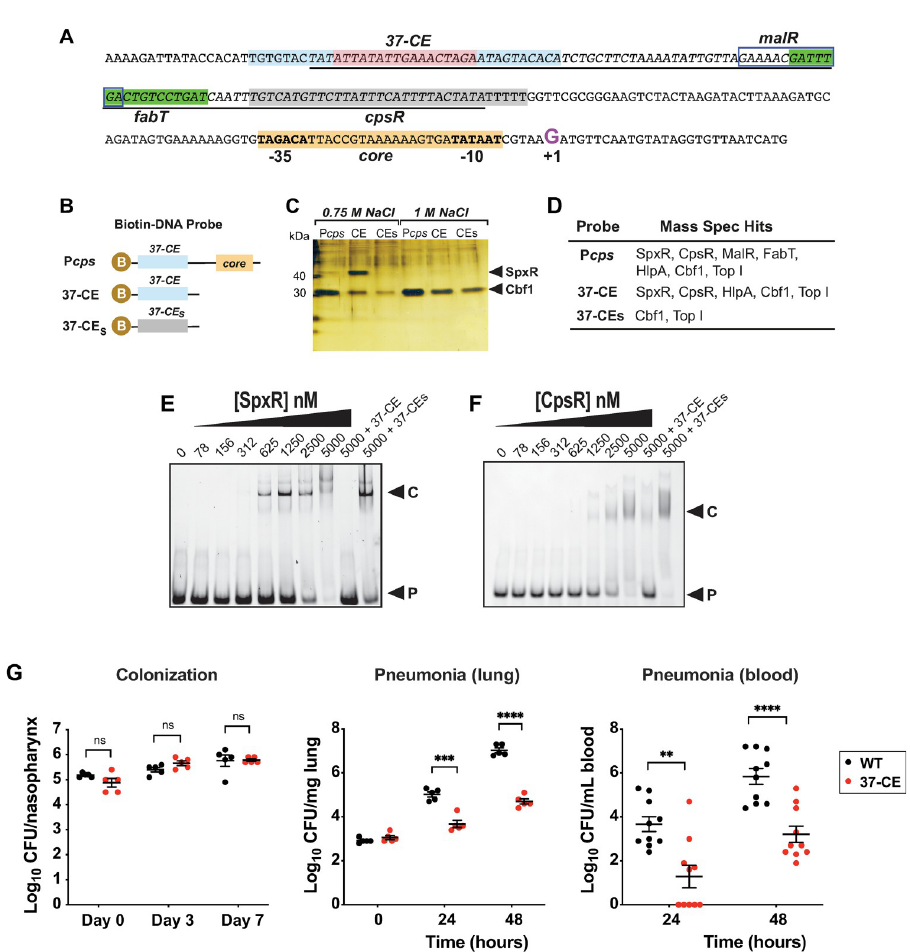
Fig 1. Identification and characterization of the 37-CE . ( A ) Annotated P sequence. The 37-CE is highlighted; the cps 10 bp perfect inverted repeat sequence is light blue while the 17 bp spacer region is pink. Proposed FabT and CpsR binding sites as identified in refs. (27) and (19, 26) are in green and grey, respectively. The proposed MalR binding site according to refs. (24, 25) is boxed. Core promoter elements are highlighted in orange. The Repeat Unit of Pneumococcus (RUP) sequence (34, 35), is underlined and the +1 transcriptional start site (G) is in purple. ( B ) Biotin interacting partners. P = full cps promoter; 37-CE = 37 bp cis (B) labelled DNA probes used to pull-down P cps cps element; 37-CEs = scrambled 37-CE sequence. ( C ) Silver-stained SDS-PAGE of biotin-conjugated DNA probe high salt eluates after bacterial lysate was bound and washed. SpxR and Cbf1 are indicated by the arrows. ( D ) Table of transcription factors identified using Mass Spectrometry (MS) by the three probes. ( E ) Representative EMSA of SpxR and ( F ) CpsR interaction with 37-CE double-stranded DNA probe. Excess unlabeled probe (+ 37-CE ) or scrambled probe (+ 37-CEs ) are used as controls. EMSAs were performed three times. ( G ) Murine infection studies. For colonization (left), mice were infected with 5x10^5 CFU and CFUs were determined on day 3 (5 mice/group) and day 7 (5 mice/group). For pneumonia, mice were infected with 5x10^6 CFU and CFUs were determined in lung homogenates (middle; 5 mice/group) and blood (right; 10 mice/group) at 24 and 48 hours post-infection. Individual data points, the mean and SEM are plotted. Statistical differences were determined using an unpaired t-test. Symbols: ns = not significant ��� p � 0.001, ���� p �